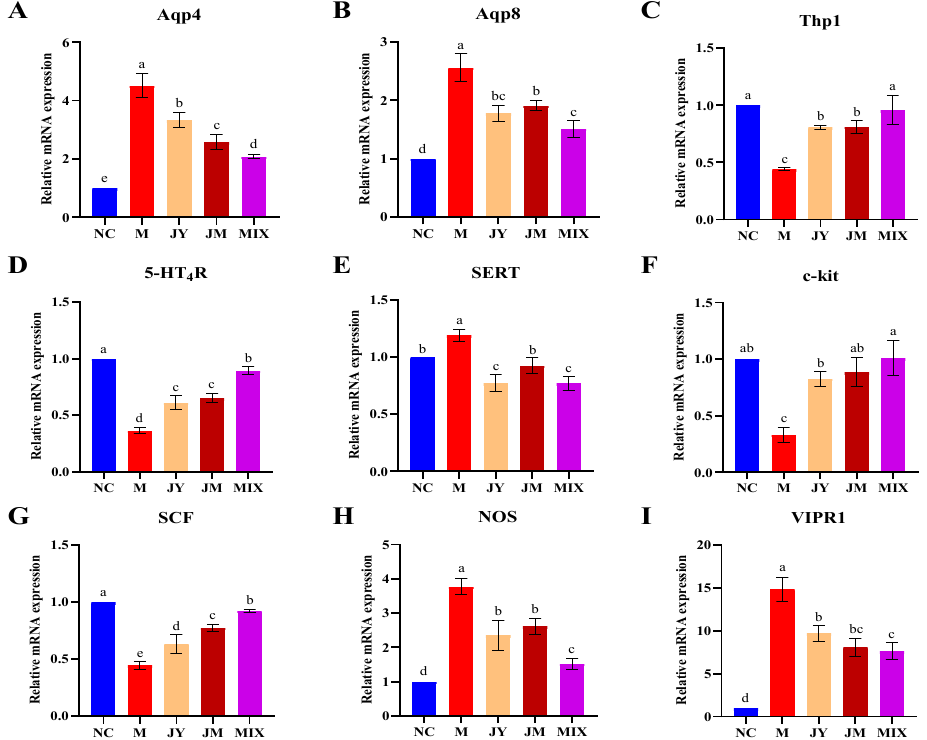
Figure 3. Regulatory effect of probiotics on related genes in mice: ( A ) mRNA relative expression of Aqp4; ( B ) mRNA relative expression of Aqp8; ( C ) mRNA relative expression of Thp1; ( D ) mRNA relative expression of 5-HT 4 R; ( E ) mRNA relative expression of SERT; ( F ) mRNA relative expression of c-kit; ( G ) mRNA relative expression of SCF; ( H ) mRNA relative expression of NOS; ( I ) mRNA relative expression of VIPR1. Different letters (a, b, c, d and e) denote significant differences between different groups of mice ( p < 0.05). NC stands for the normal control group, M for the model group, JY for the L. paracasei JY062 group, JM for the L. gasseri JM1 group, and MIX for the combination group.